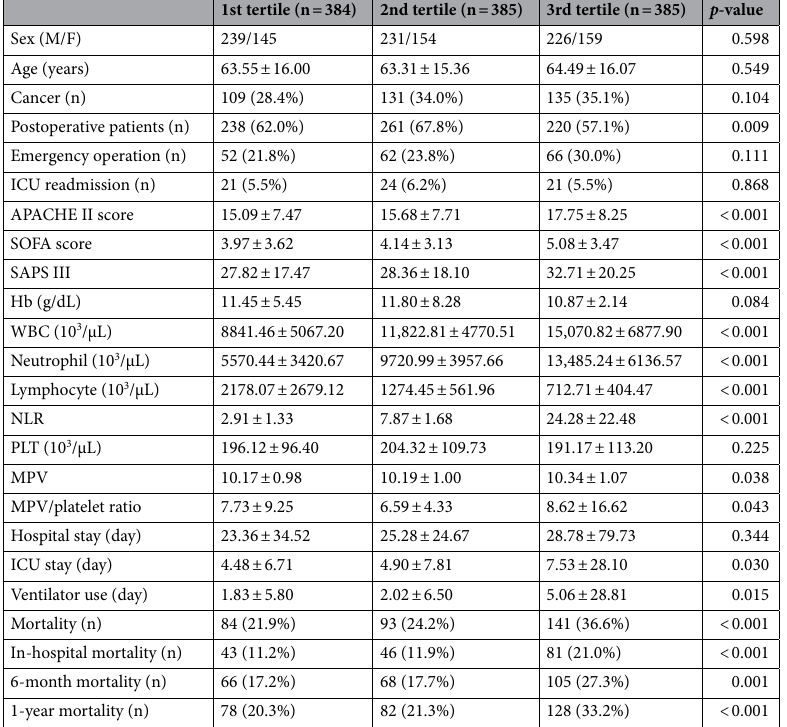
Table 2. Baseline characteristics and outcome variables across NLR tertiles. Values are presented as the mean ± standard deviation or number of patients (%). ICU, intensive care unit; APACHE II, Acute Physiology and Chronic Health Evaluation; SOFA, Sequential Organ Failure Assessment; SAPS III, Simplified Acute Physiology Score; Hb, haemoglobin; WBC, white blood cell; NLR, neutrophil to lymphocyte ratio; PLT, platelet; MPV, mean platelet volume; HOD, hospital